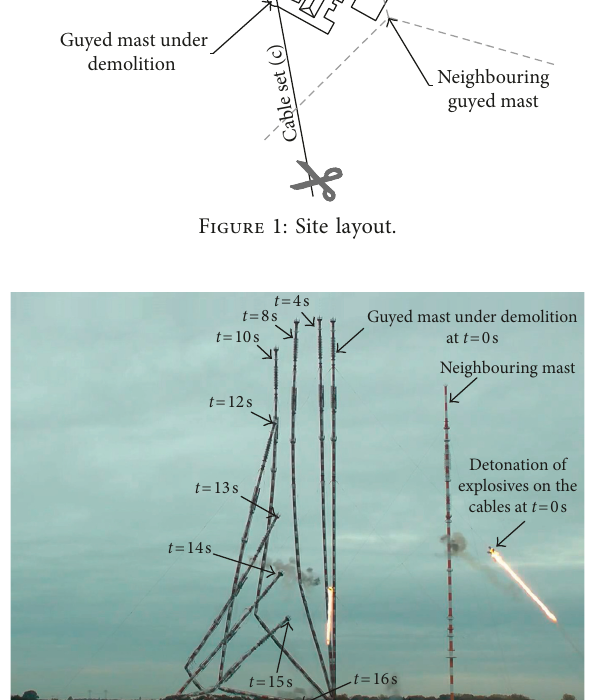
Figure 1: Site layout.